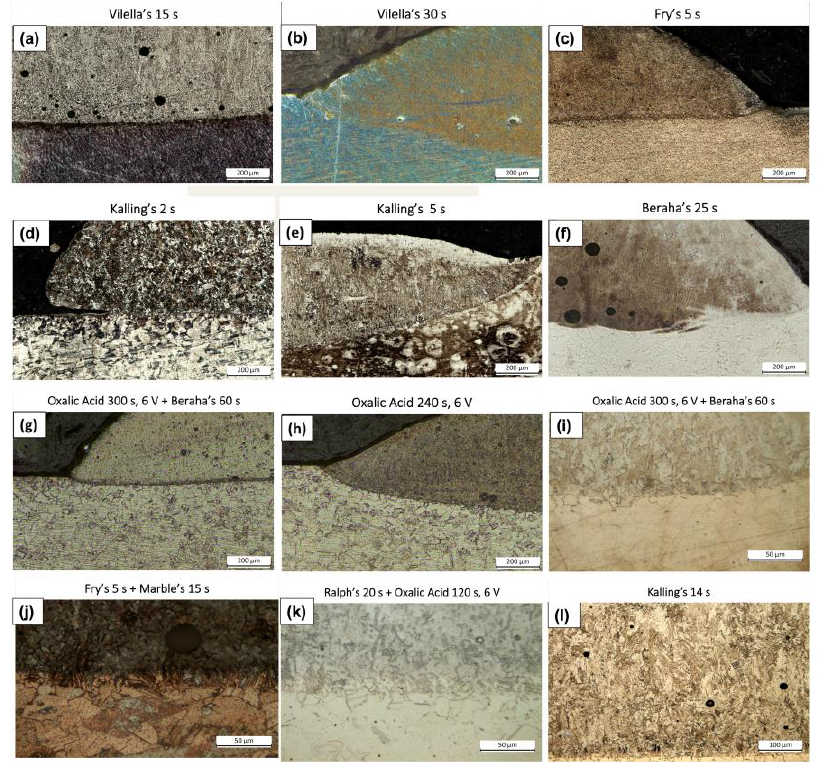
Figure 6. ( a – l ) Microstructures of the deposition revealed with different etching strategies: the corresponding etching procedure is reported above each micrograph.